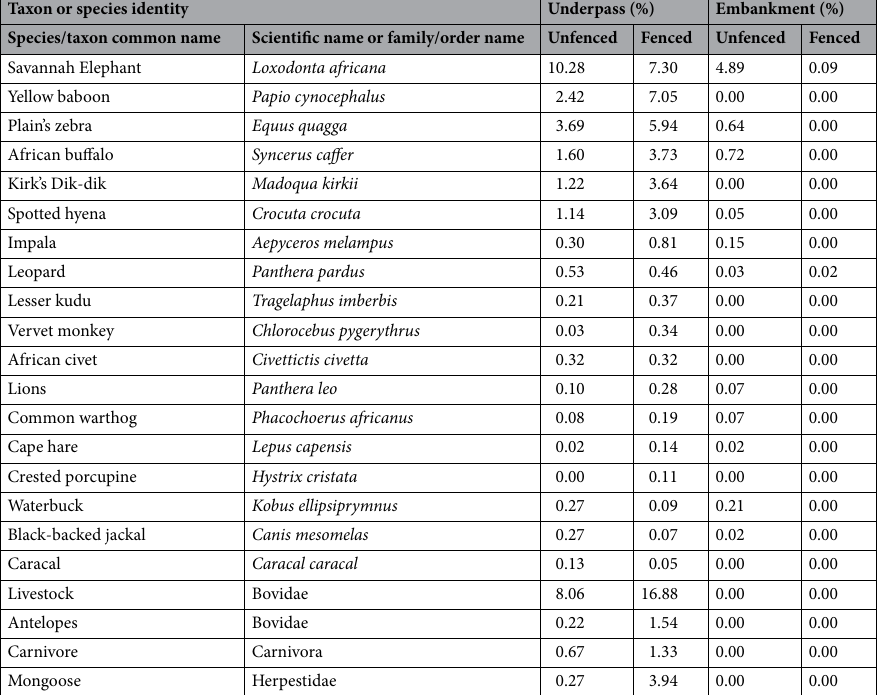
Table 2. The influence of electric fencing on the percentage use of SGR underpasses by wildlife in the